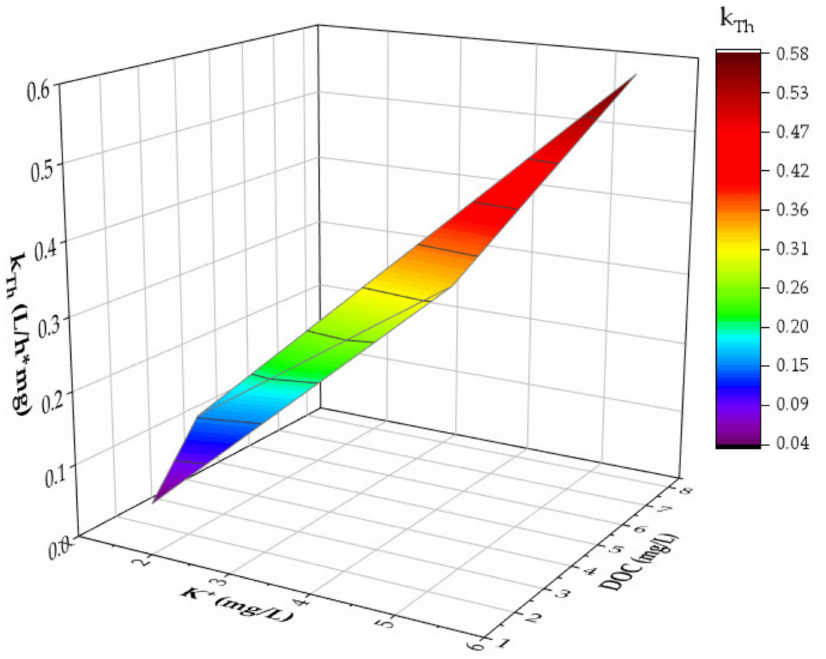
Figure 4. Two-factor variance analysis of k Th as a function of K + and DOC concentrations (matrix: natural; c 0 (DOC) = 1.76–7.88 mg/L; c 0 (K + ) = 1.63–5.44 mg/L v F = 1.74 m/h; EBCT: 2.16 min; pH 0 : 7.8; T = 22 ◦ C; n =